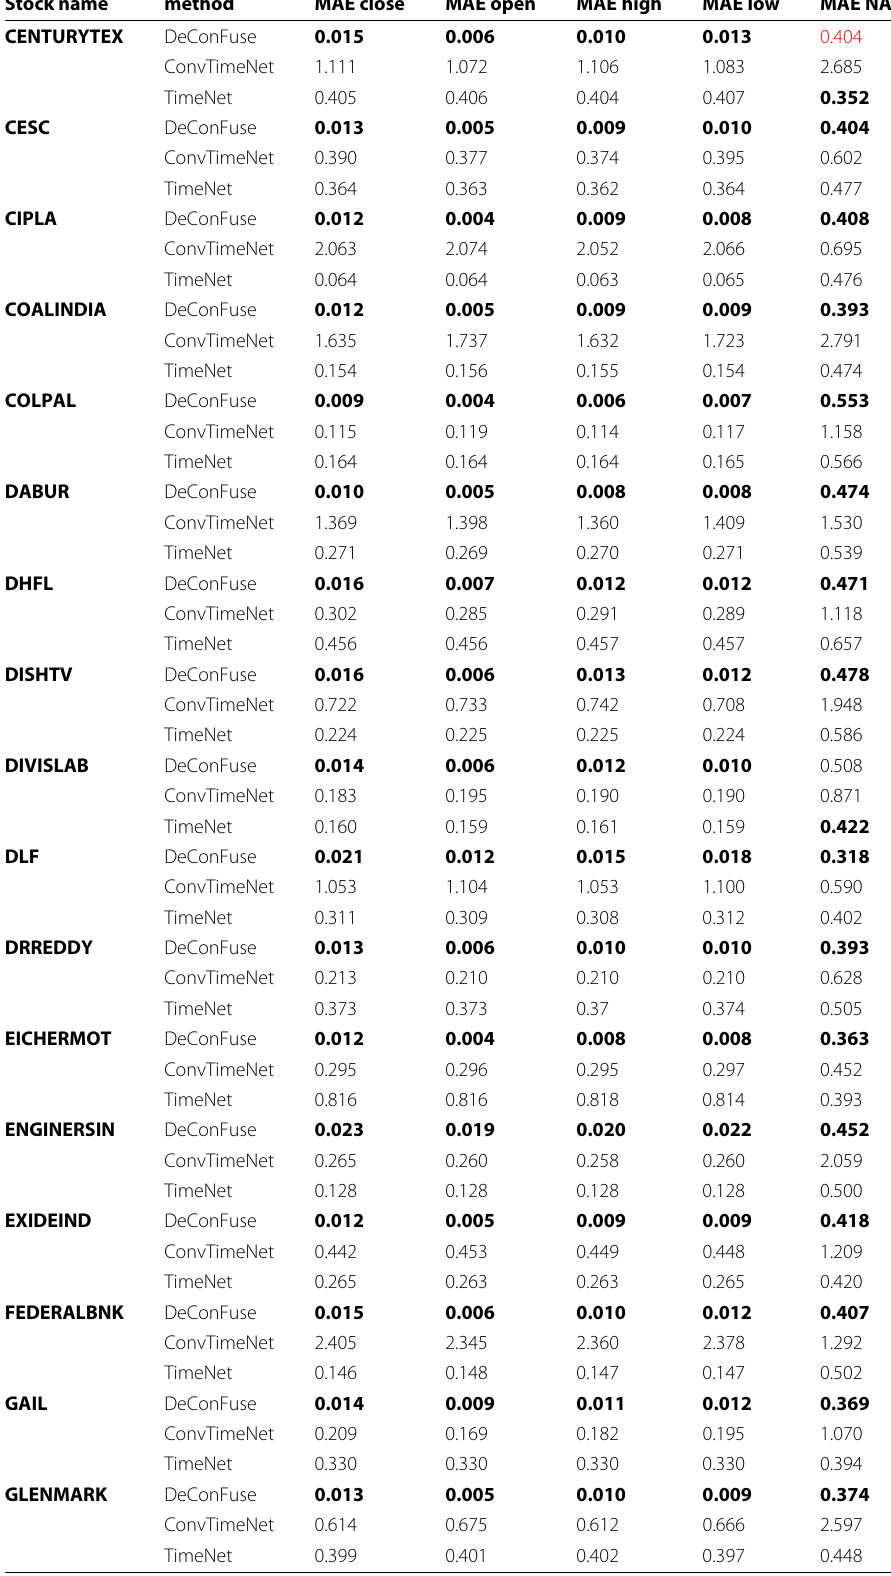
Table 5 Stock-wise forecasting results ( Continued